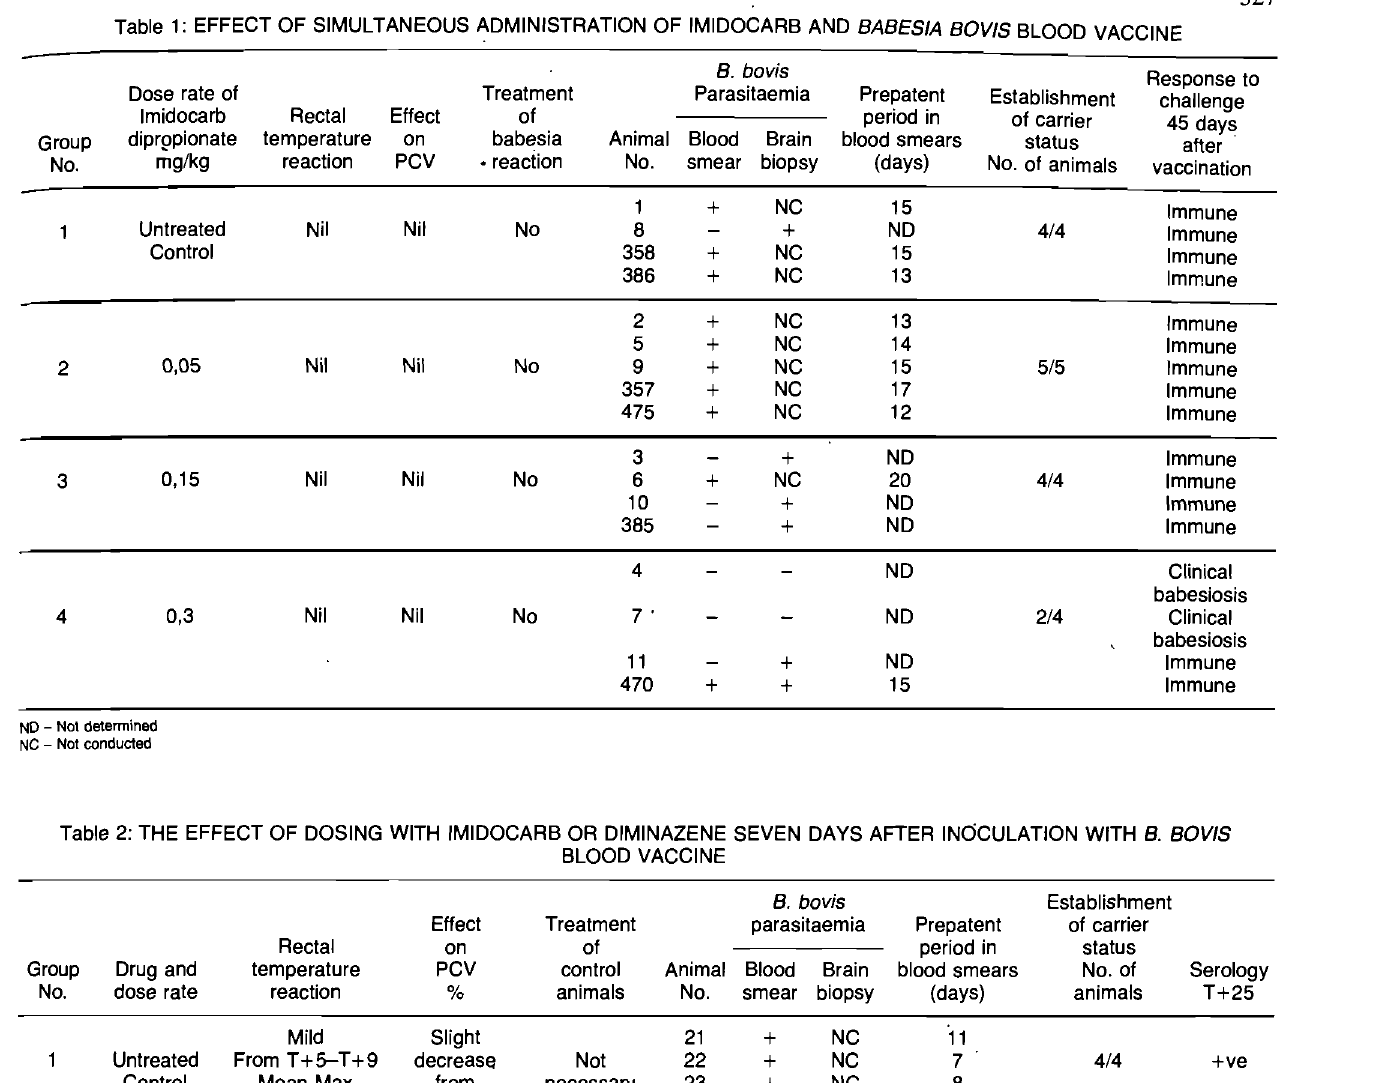
Table 2: THE EFFECT OF DOSING WITH IMIDOCARB OR DIMINAZENE SEVEN DAYS AFTER INOCULATION WITH B. BOVIS BLOOD